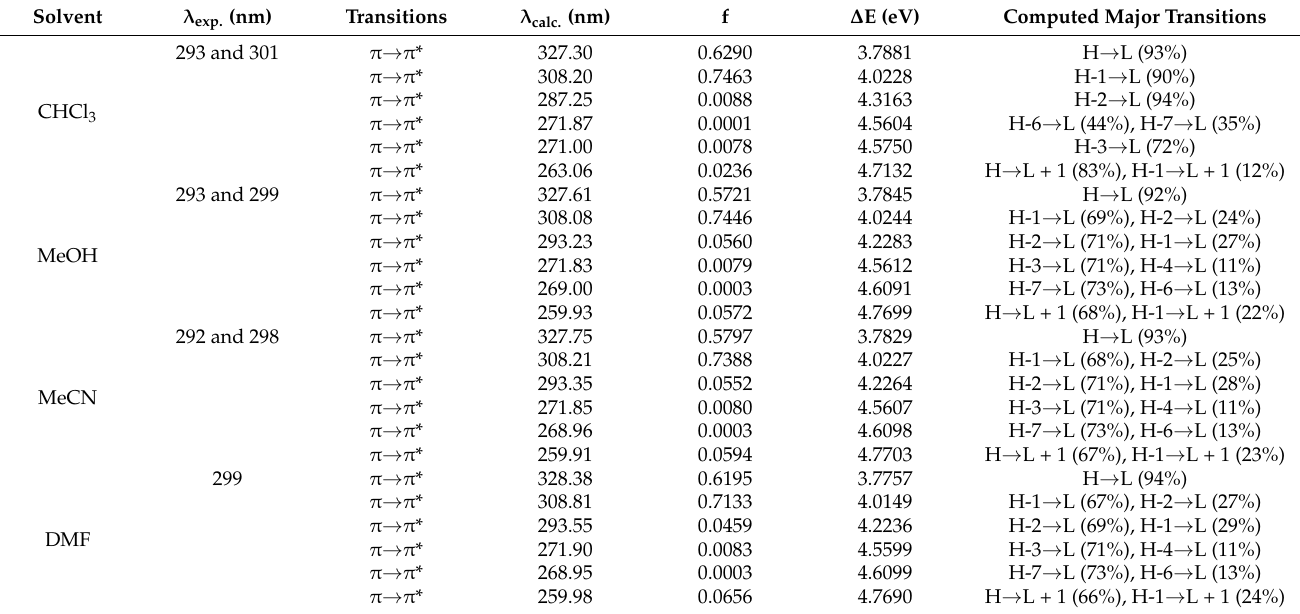
Figure 8. Experimental and simulated UV spectra of 2 . Table 4. Experimental absorption wavelengths and computed UV spectral parameters of 2